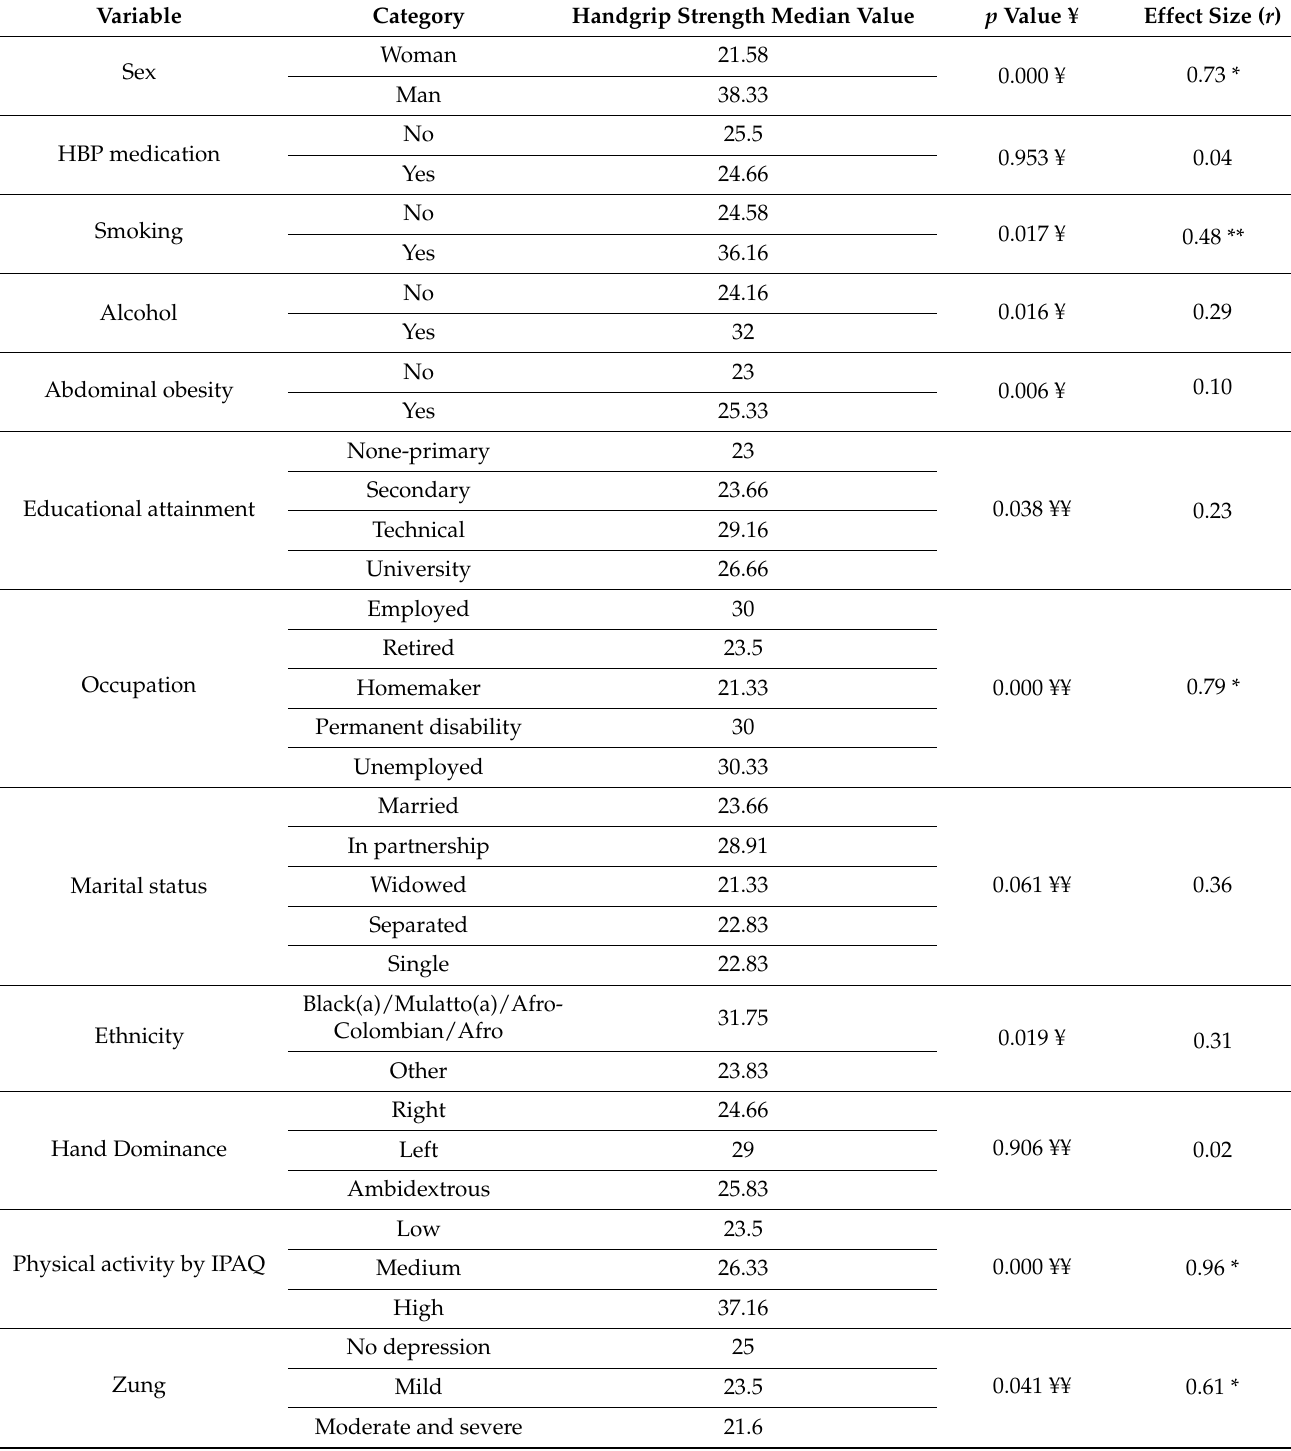
Table 2. Handgrip strength values by sociodemographic and clinical